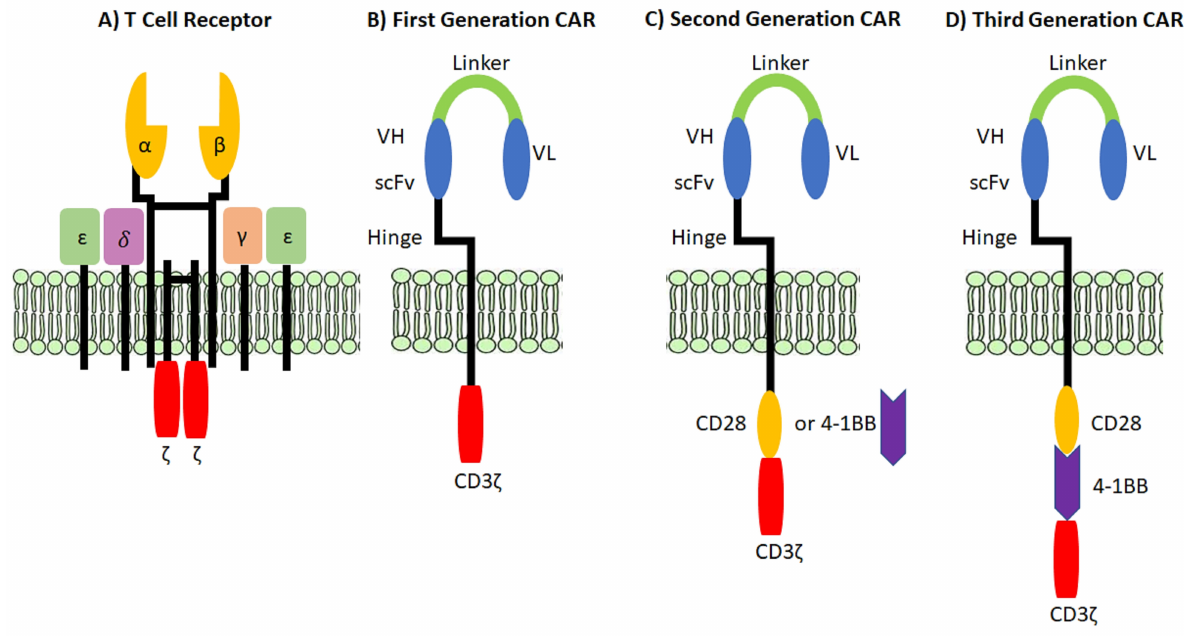
Figure 2. TCR structure compared to 1st, 2nd, and 3rd generation CARs. T cell receptors and chimeric antigen receptors differ significantly in their structure and how they recognize antigen. ( A ) T cell receptors are an αβ heterodimer that associates with the CD3 complex. CD3 consists of 6 chains, an ε - δ heterodimer, an ε - γ heterodimer, and a ζ - ζ homodimer. Chimeric antigen receptors consist of a scFv fused to a hinge (usually CD8), transmembrane region, and ( B ) CD3 ζ (first generation CAR) or ( C ) CD28 or 4-1BB and CD3 ζ (second generation CAR) or ( D ) CD28 and 4-1BB and CD3 ζ (third generation